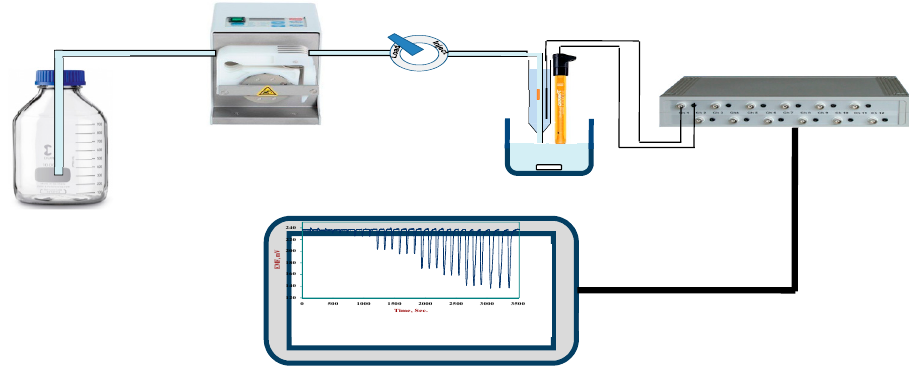
Figure 6. Flow-injection setup: (1) NaCl-acetate buffer reservoir, (2) peristaltic pump, (3) injection valve, (4) cell assembly, (5) double junction reference electrode, (6) high (Z) box, (7) typical flow-transient plot.